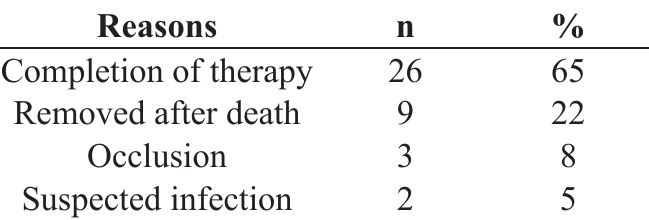
TABLE 2 - Antecedent diagnosis of patients.